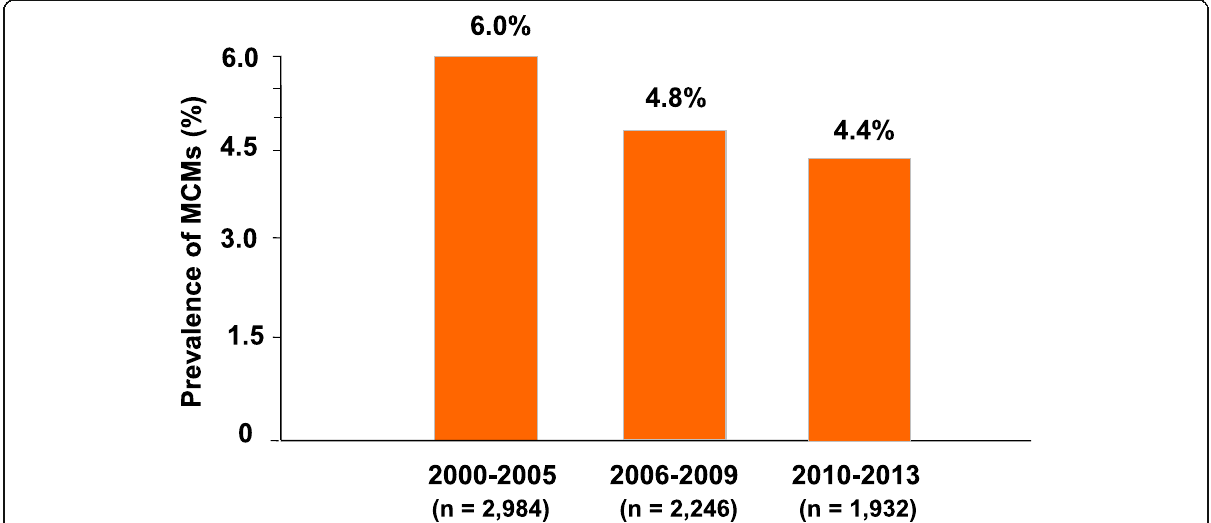
Fig. 1 Prevalence of major congenital malformations (MCMs) following prenatal exposure to monotherapy with antiseizure medications (ASMs) among cases enrolled in the EURAP international registry during three different periods. Number of exposures during each period (listed in brackets) refer to the eight most common monotherapies, which accounted for 96.7 to 98.1% of all monotherapy exposures. Based on data from Tomson et al